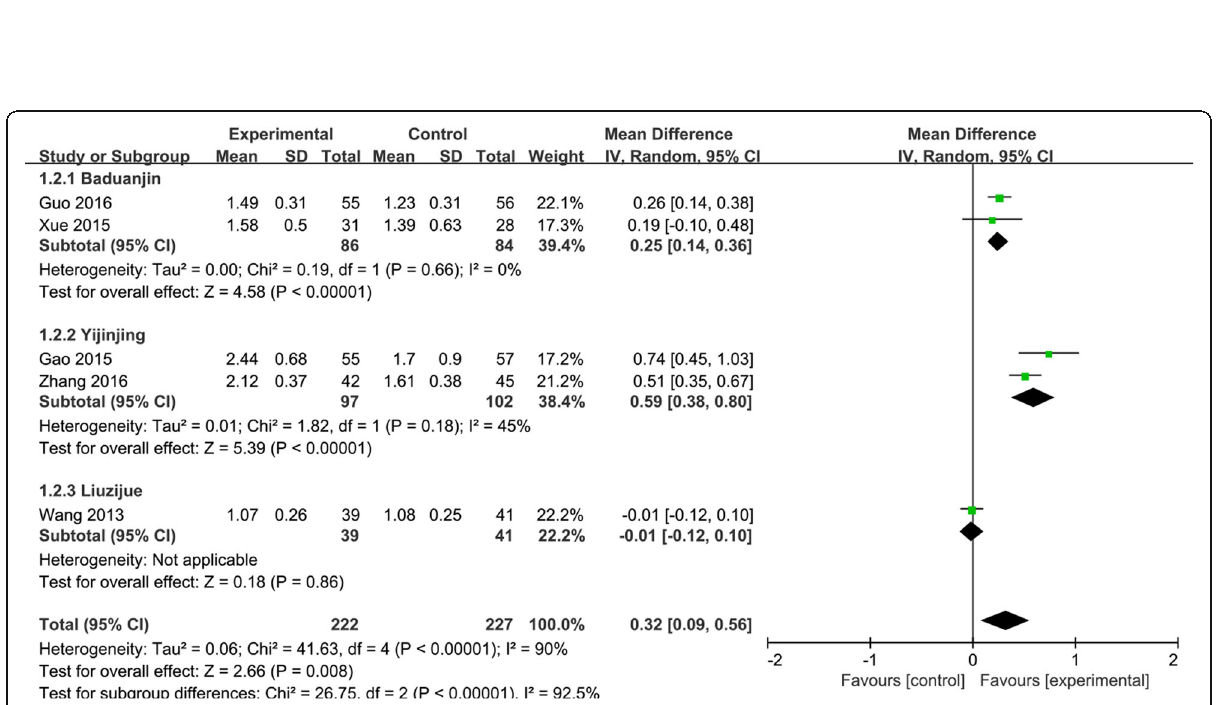
Fig. 3 Effects of Qigong on forced expiratory volume in 1 s (FEV1). Subgroup meta-analysis was used to assess the effects of different types of Qigong on FEV1 with a random effects